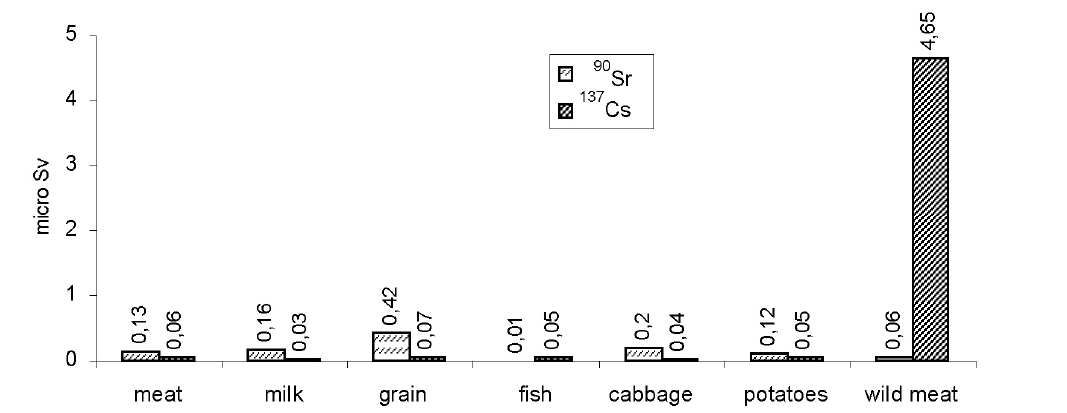
Fig 3. Components of total dose for hunters and members of their families due to 90 Sr and 137 Cs in daily food (data for 2005 [20]) and in meat of game (data for two hunting seasons in 2003–2005), µ